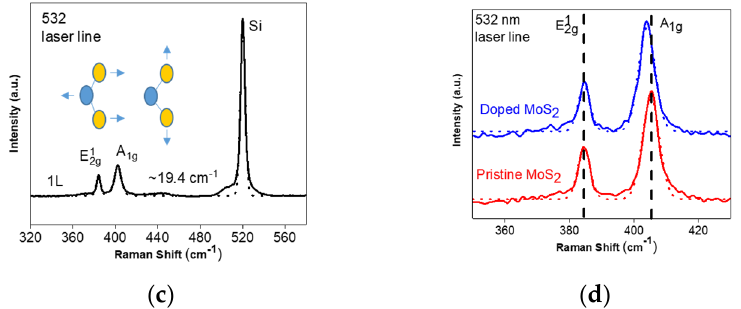
Figure 2. ( a ) Optical microscope image, ( b ) AFM height profile, and ( c ) Raman spectroscopy results using a laser with an excitation wavelength of 532 nm for a monolayer of CVD-grown MoS 2 flakes. ( d ) The two Raman modes for the pristine and doped monolayer MoS 2 flakes.